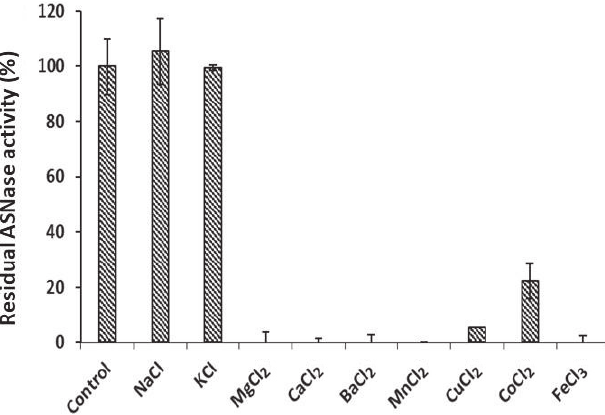
Fig. 4 – Effect of ions on l -asparaginase from Enterobacter sp. strain M55